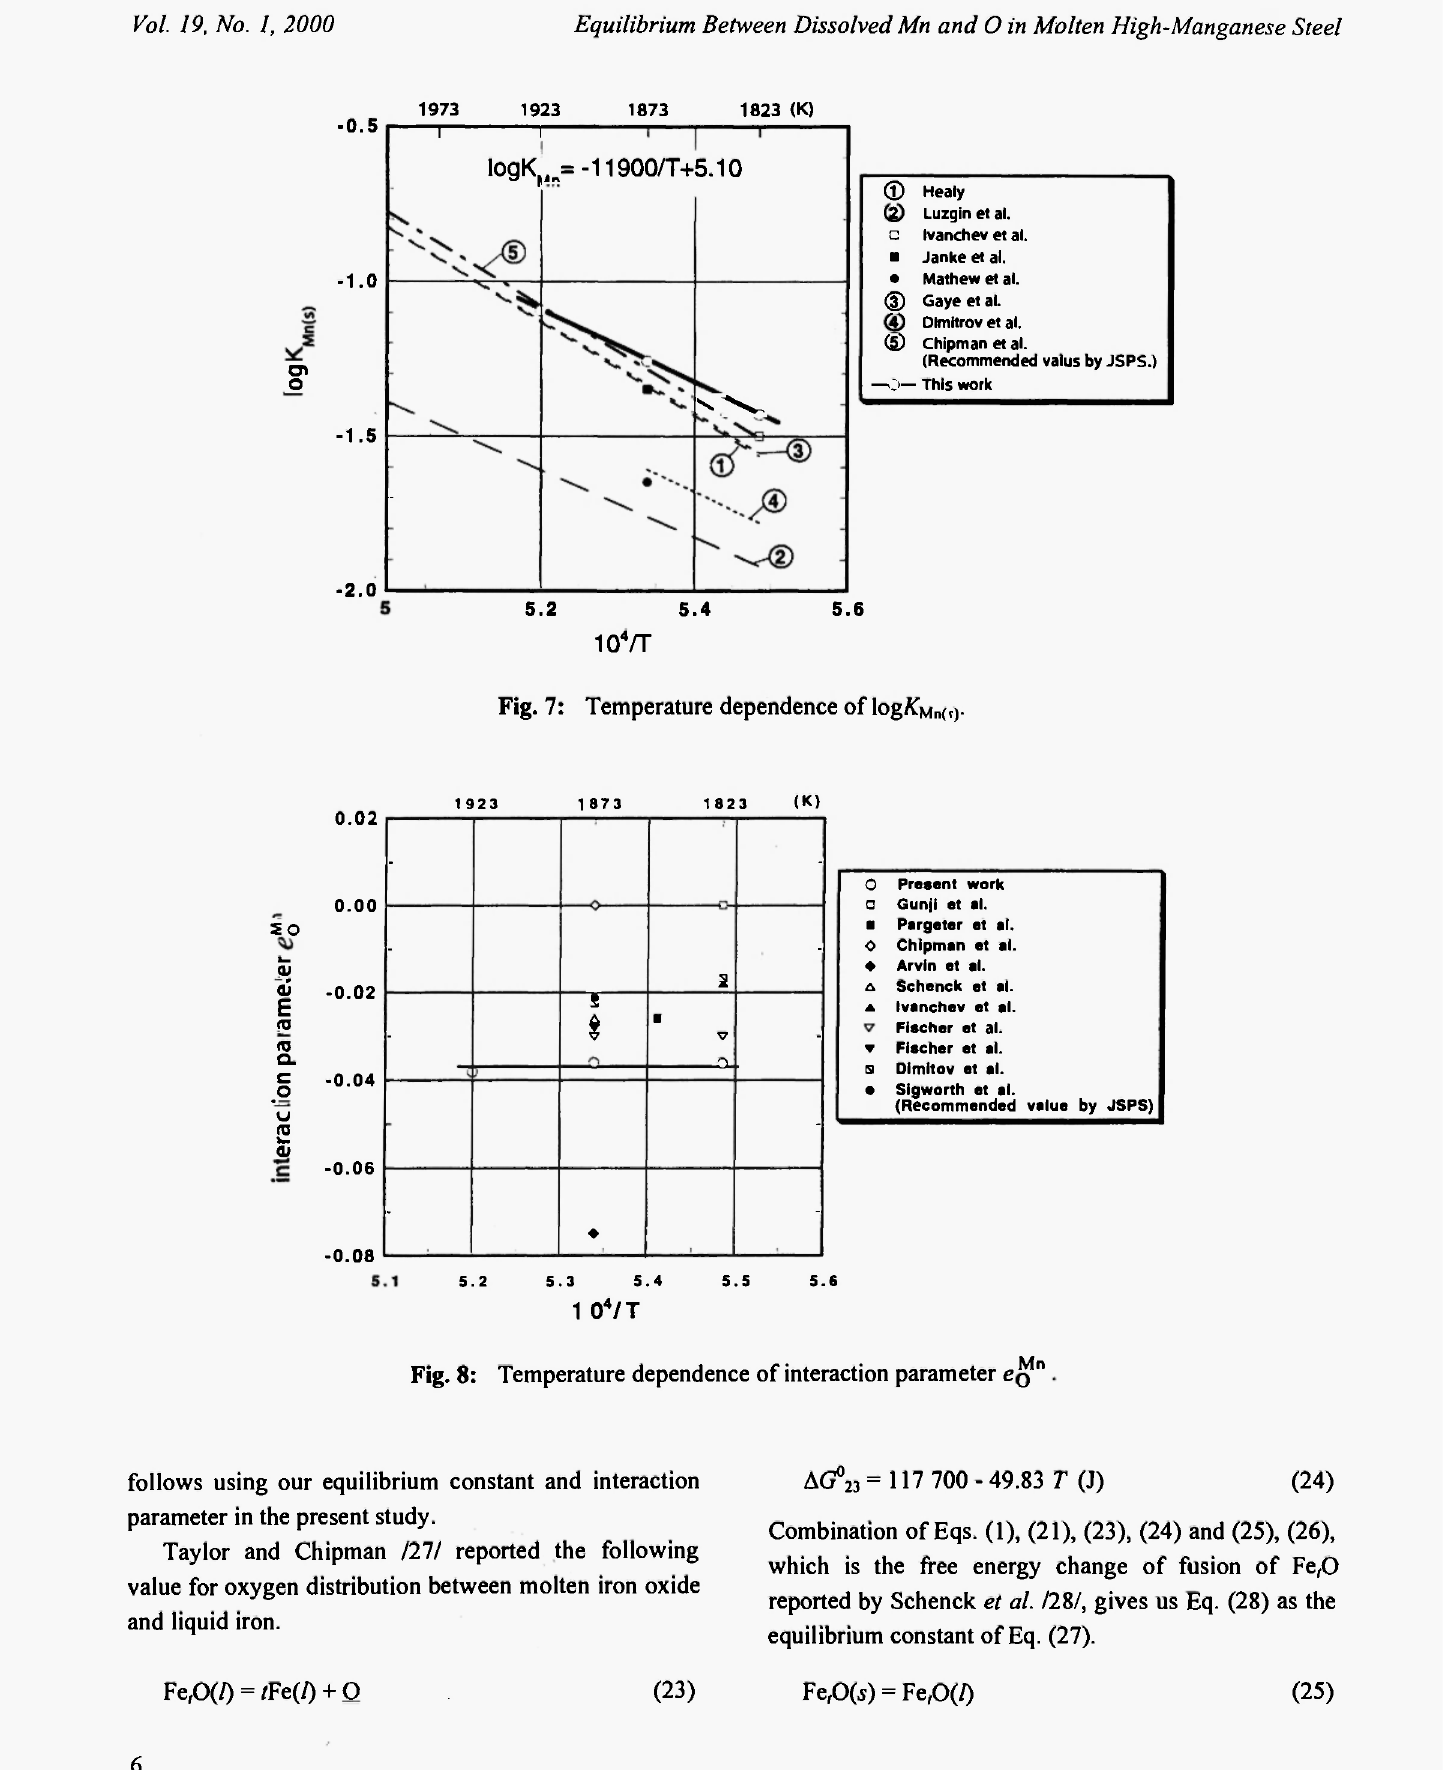
Fig. 7: Temperature dependence of log^ Mn( ,).